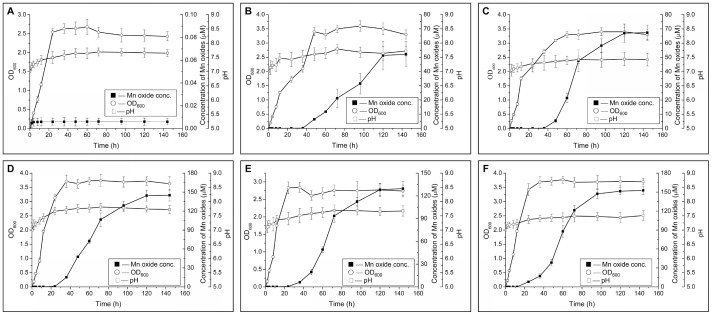
Time course of the Mn(II)-oxidizing activities and the cell growth of several isolates from A-, B-, and C-layer soils.The cells were grown in liquor K medium for 144(OD600) and the concentration of Mn oxides were determined according to the procedures described in the “Materials and Methods” section. (○) Optical density of the cells (at 600 nm); (▪) Concentration of Mn oxides; (□) pH. A: Non-Mn(II)-oxidizing E. coli JM109 (as the negative control). B: A86. C: A101. D: B84. E: C19. F: C13.